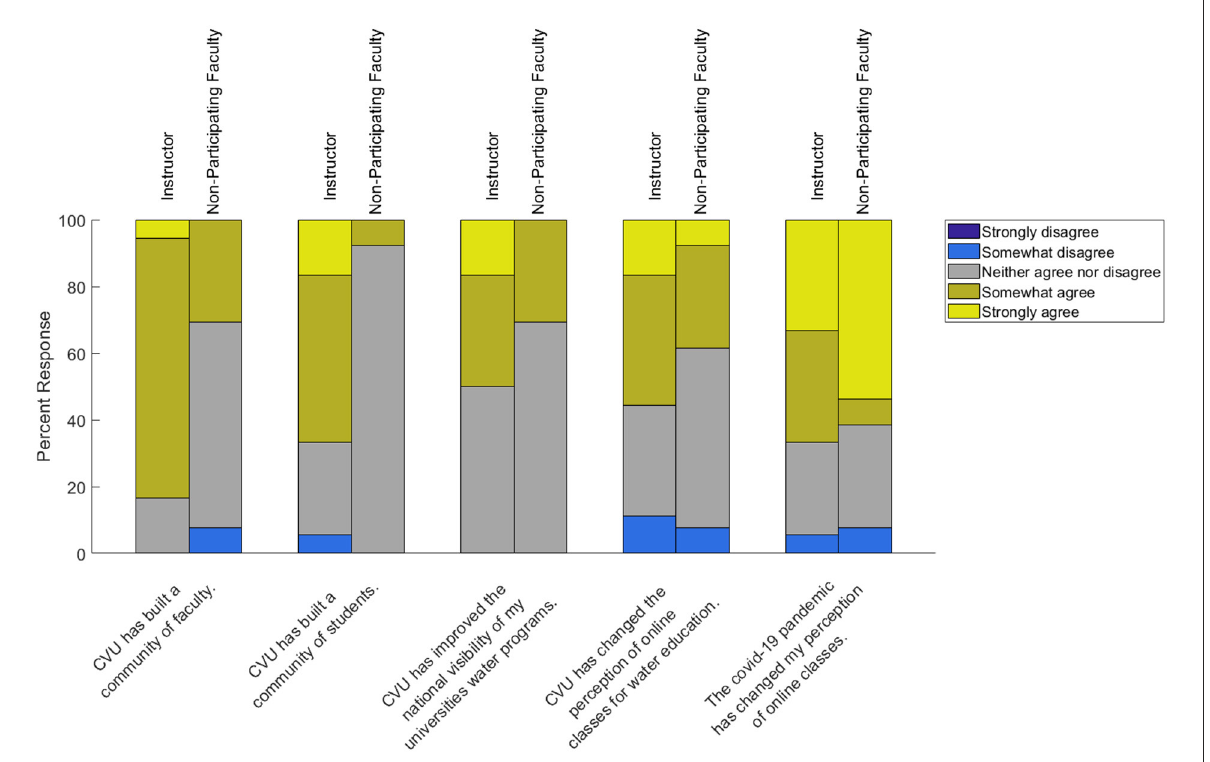
FIGURE4 Levels of agreement with statements about CVU’s role in community creation and online